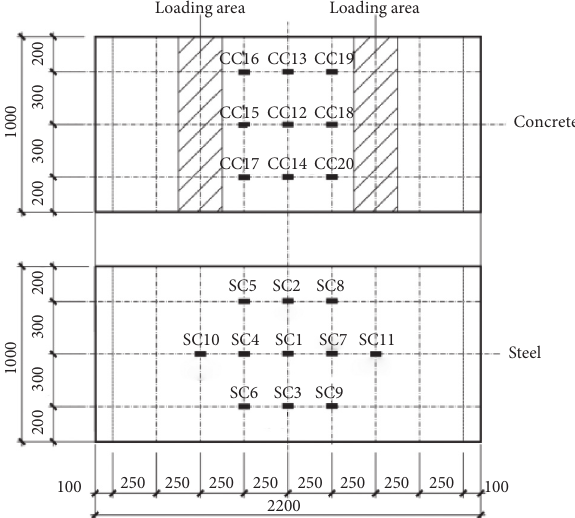
Figure 11: Arrangement of strain measuring points for jointless specimens in flexural experiment (unit: mm).